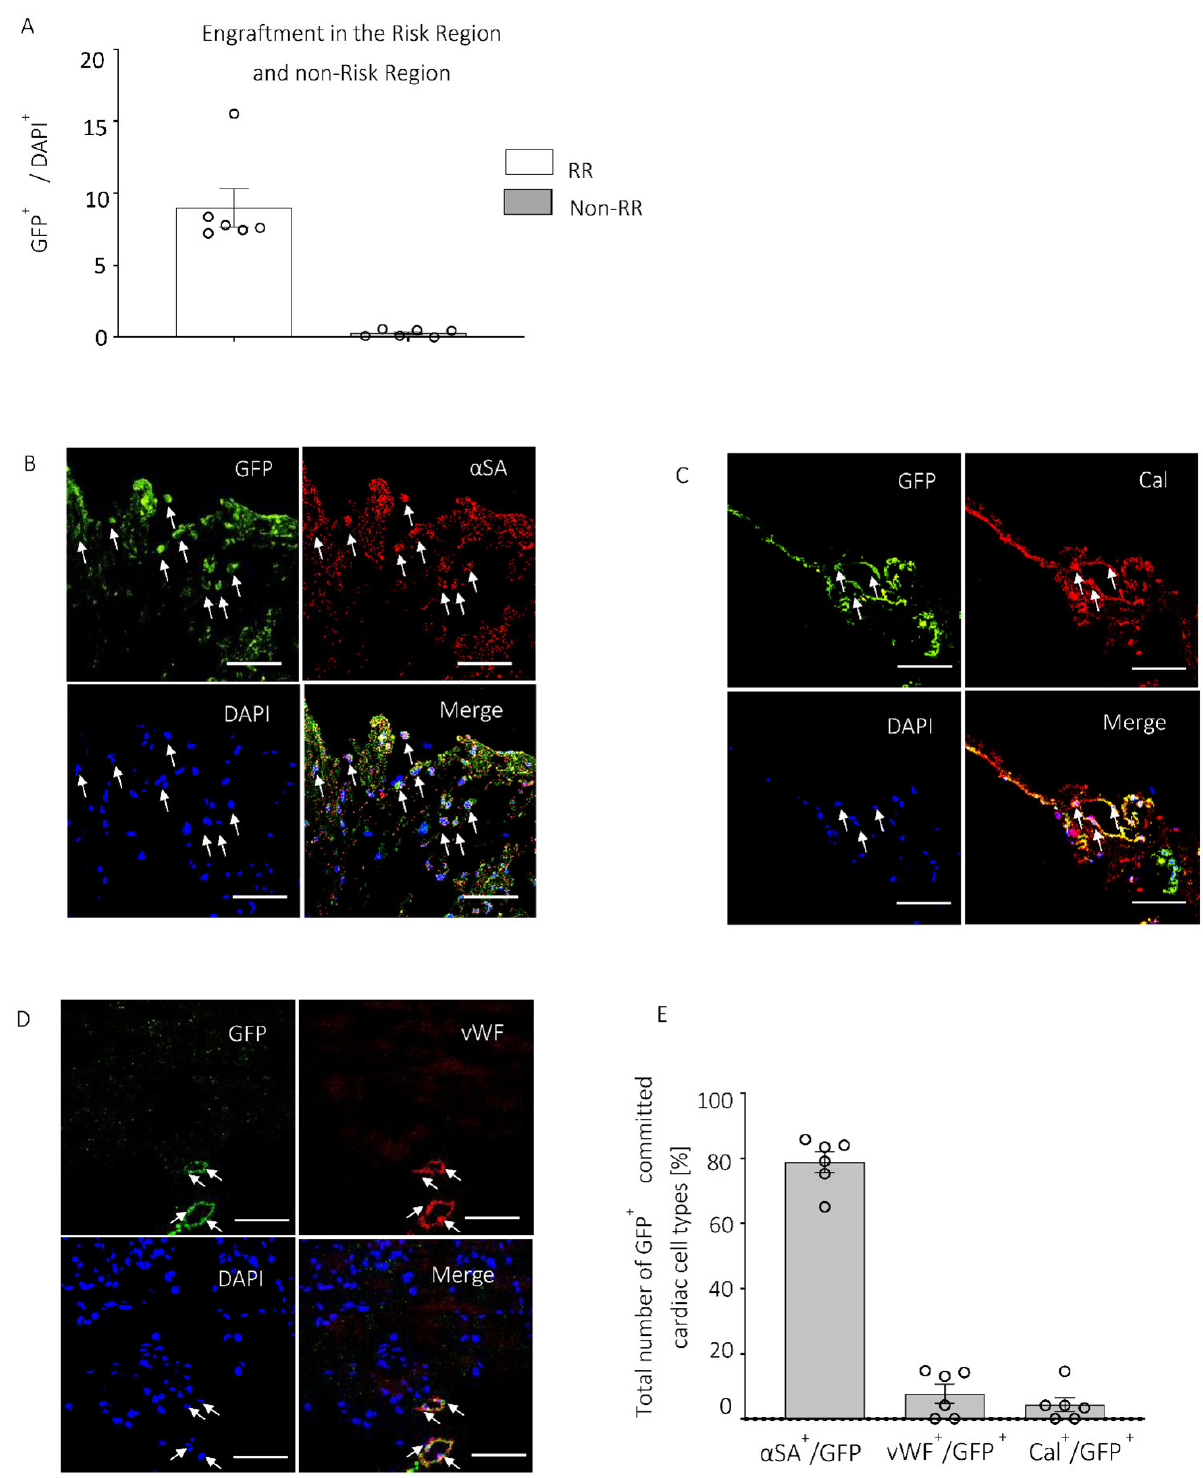
Figure 3. PICs engraft in the infarcted myocardium. ( A ) Percent engraftment of GFP + PICs 6 weeks post-transplantation, represented as a percentage of the total number of DAPI cells in the risk region (RR) and non-risk region (non-RR). Data are Mean ± SEM in 20 FOV per mouse. ( B – D ) Representative confocal micrographs of GFP + PICs (green) expressing markers of cardiomyocyte (( B ), Red; α -sarcomeric actin), smooth muscle (( C ), Red; calponin) and endothelial (( D ), Red, vWF) cells. DAPI stain nuclei blue. Scale bar = 50 µ M. ( E ) Quantification of the GFP + PICs expressing markers of the cardiac tr-lineage in MI-PICs group n = 6. Data are Mean ±